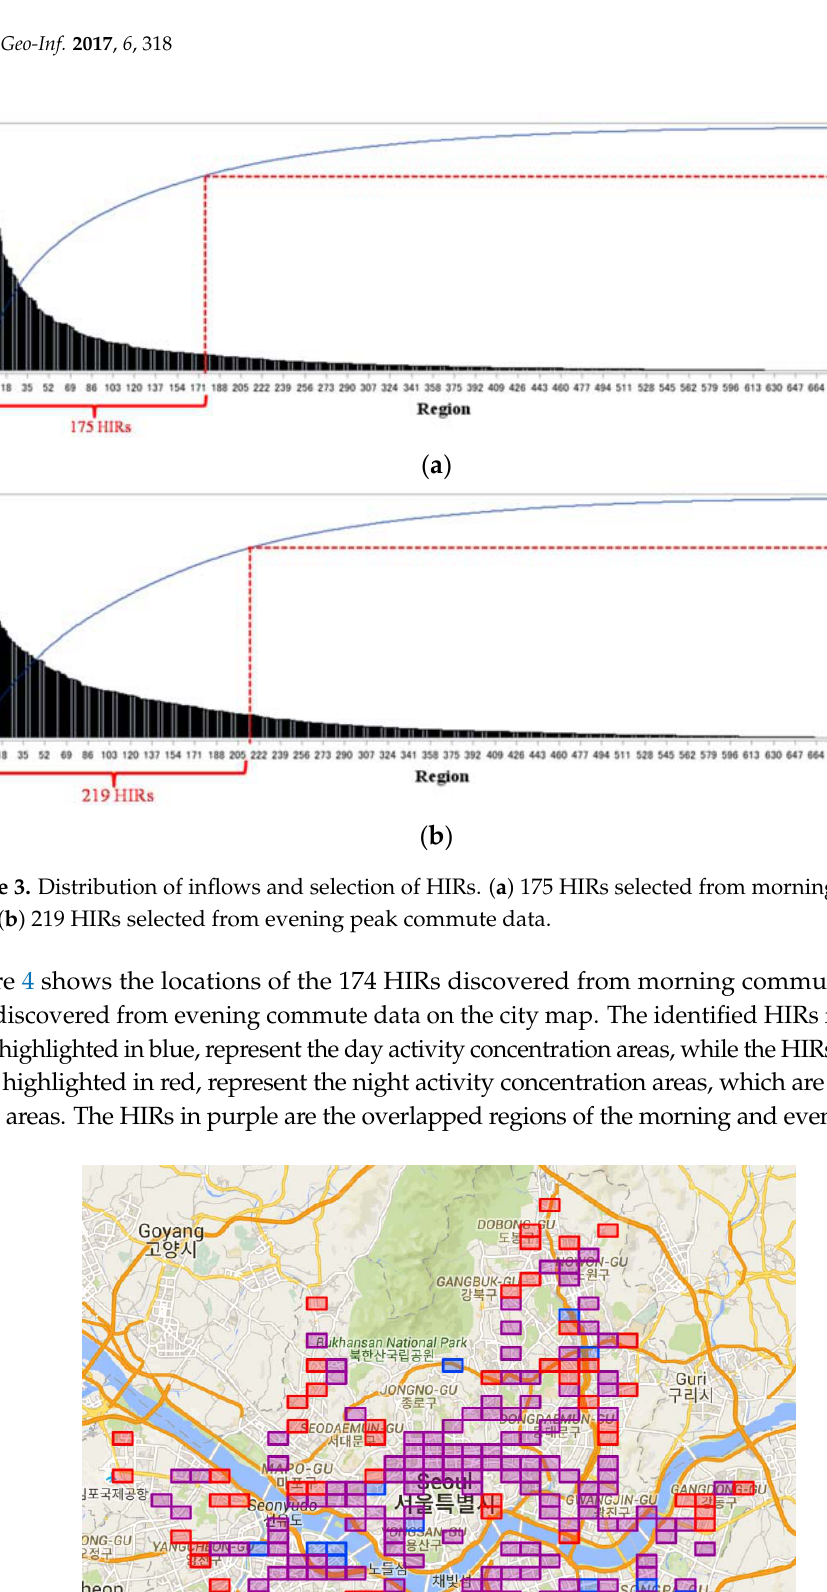
Figure 4. HIRs extracted in Seoul. 159 HIRs in purple both for morning and evening commutes, 16 HIRs in blue only for morning commute, and 59 HIRs in red only for evening commutes.